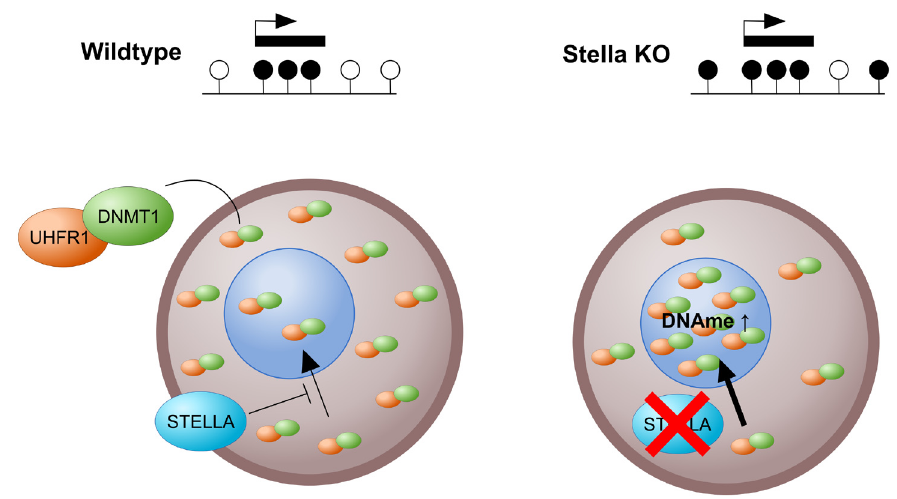
Figure 3. The role of STELLA in regulating methylation in the oocyte. In the oocyte, STELLA is required for the cytoplasmic localisation of the majority of DNA methyltransferase 1 (DNMT1)/ubiquitin-like, plant homeodomain and ring finger-containing 1 (UHRF1). Ablation of STELLA results in UHRF1/DNMT1 redistribution into the nucleus, resulting in increased DNA methylation at regions that are normally unmethylated. KO,